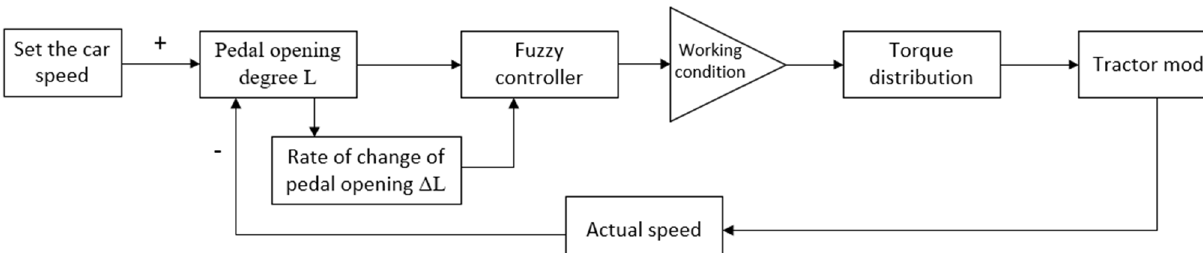
Figure 5. Speed demand torque model.